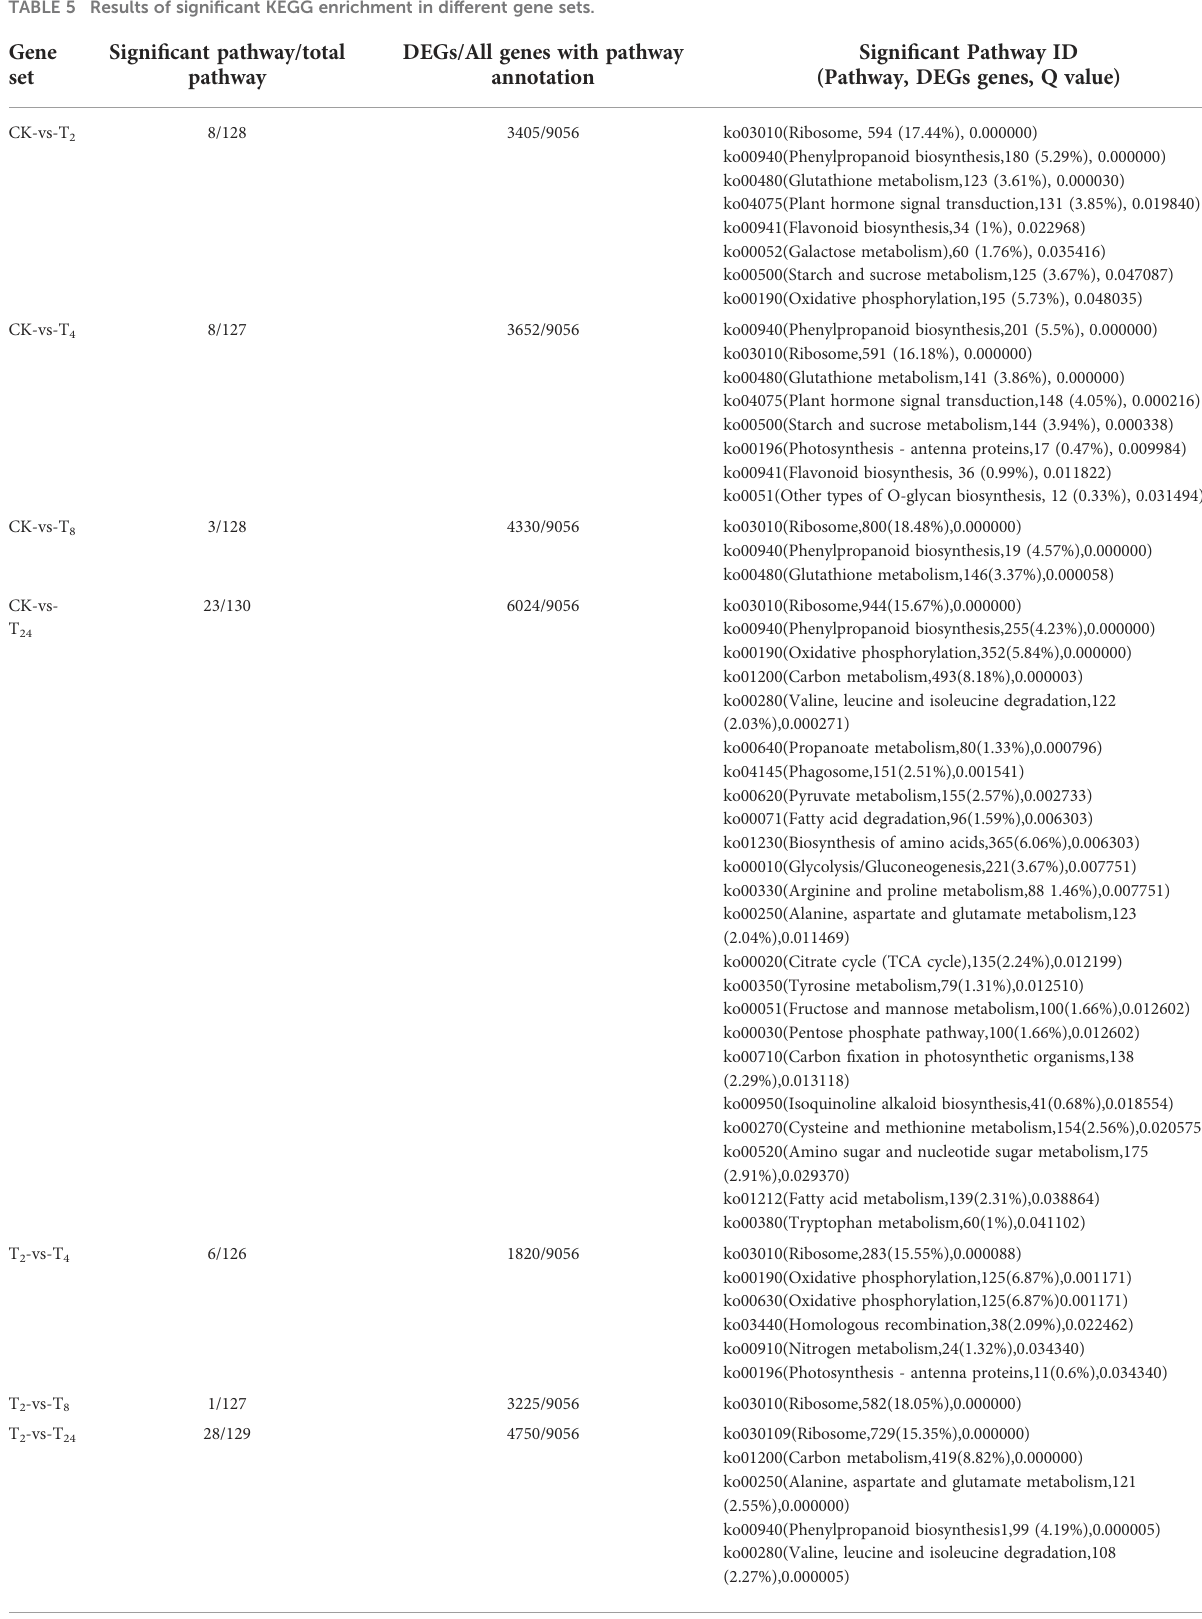
TABLE 5 Results of signi fi cant KEGG enrichment in different gene